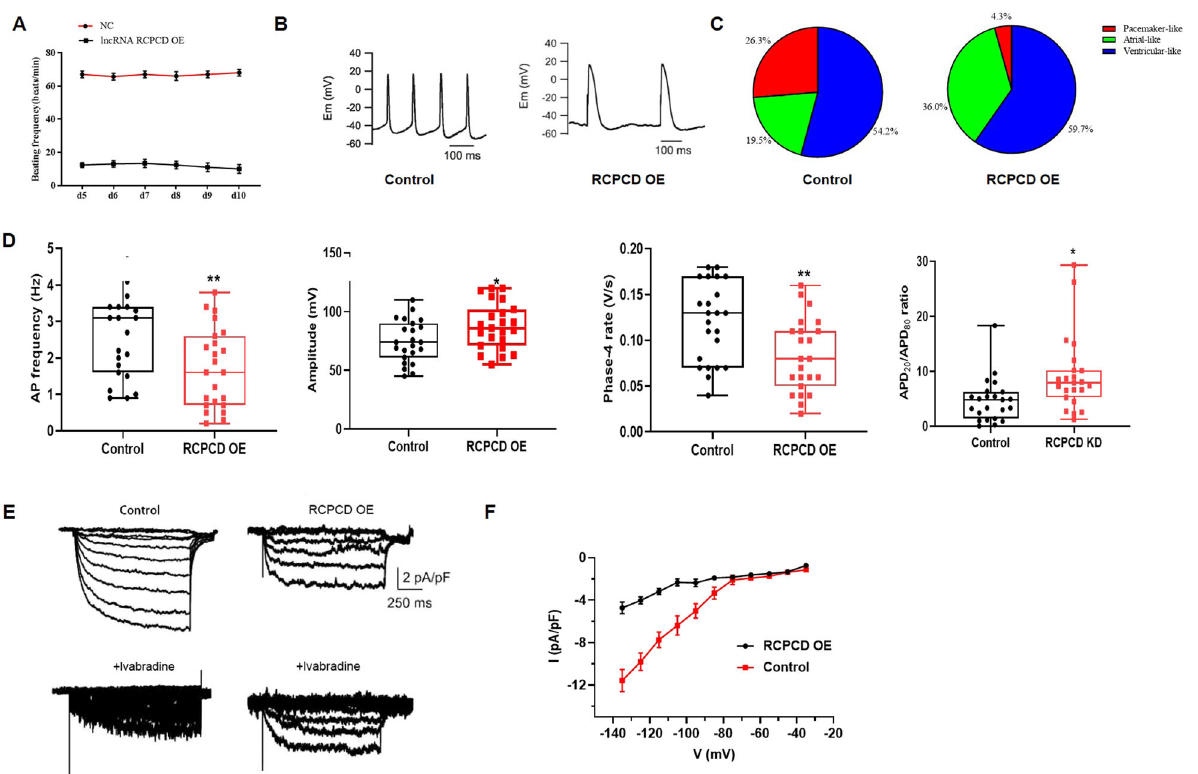
Fig. 4 LncRNA RCPCD-EBs exhibited pacemaker cell-like electrophysiology. A Beating frequency was detected at different time points during the differentiation of embryonic stem cells into pacemaker cells. B Representative raw traces of APs recorded from spontaneously beating single cells from control EBs (left) or RCPCD Overexpression EBs (right). C The ratio of pacemaker-like cells at d6 + 10. D Comparison of AP parameters (from left to right): spontaneous beating rate, the amplitude of the AP upstroke, spontaneous phase 4 diastolic depolarization rate, and the ratio of AP duration at 20% repolarization to 80% repolarization. E Representative HCN ionic currents (If) recorded from a control EB cell (left) and an RCPCD Overexpression EB cell (right). Lower panels show the inhibition of time-dependent currents upon the addition of 10 mM ivabradine in the bath solution. F Current density-voltage relationships of control and RCPCD overexpression groups. * P < 0.05, ** P < 0.01, *** P < 0.01, * as the difference that compared with the control